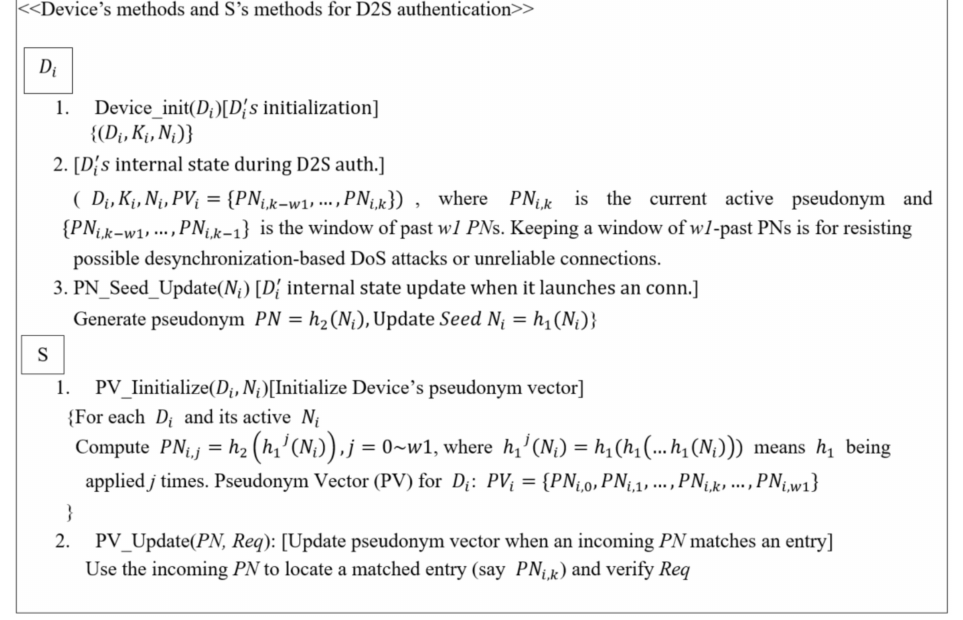
Figure 2. D i ’s methods and S ’s methods for the Level-1 D2S